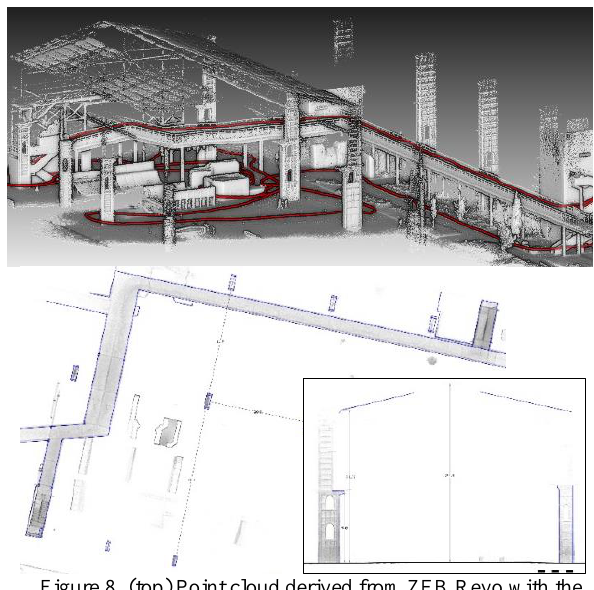
Figure 8. (top) Point cloud derived from ZEB Revo with the trajectory highlighted in red. (down) Horizontal and vertical cross-section extracted from ZEB point cloud